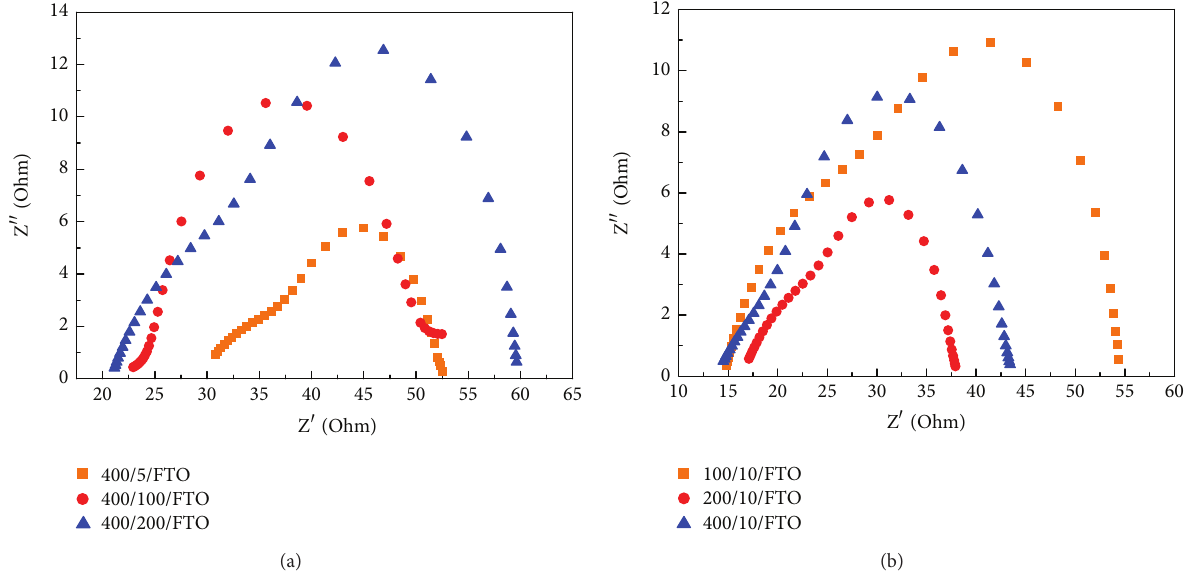
Figure 8: The EIS curves of the DSSCs prepared by double-layer structures with different TiO 2 particle sizes in the (a) bottom and (b) top layers, respectively, in the form of the Nyquist plots.